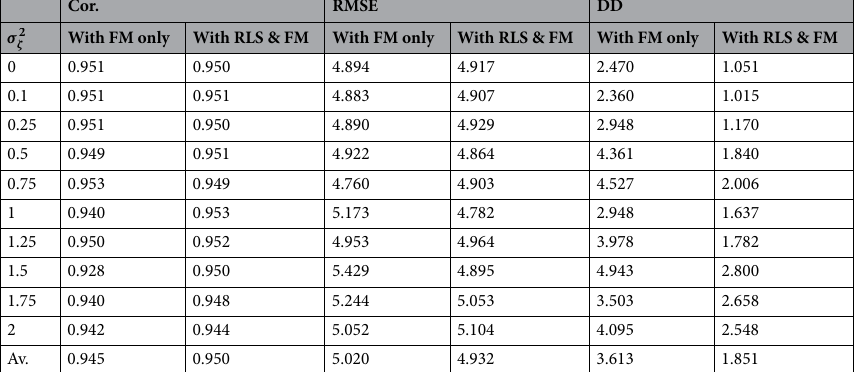
Table 9. RMSE, Correlation (Cor.) and Depth Distortion (DD) in % for shape reconstruction using FM:TENG with different levels of variance of Jitter noise ( σ 2 ξ = ( 2 ak + b ) 2 σ 2 ζ + 2 a 2 σ 4 ζ ), with and without proposed RLS filter.